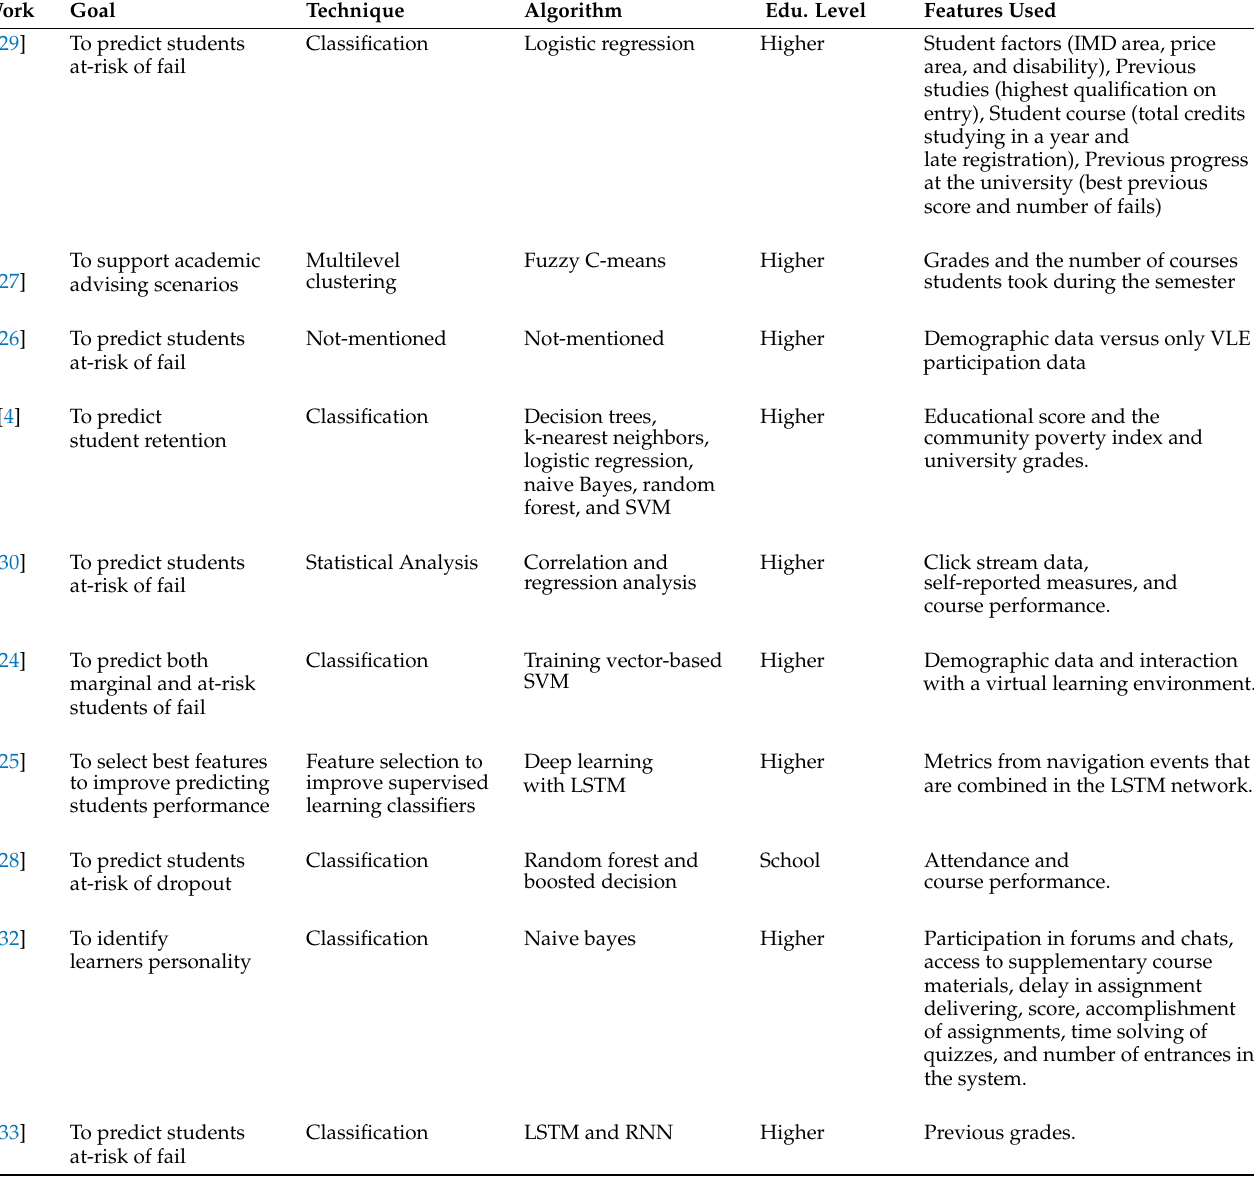
Table 1. Summary of related